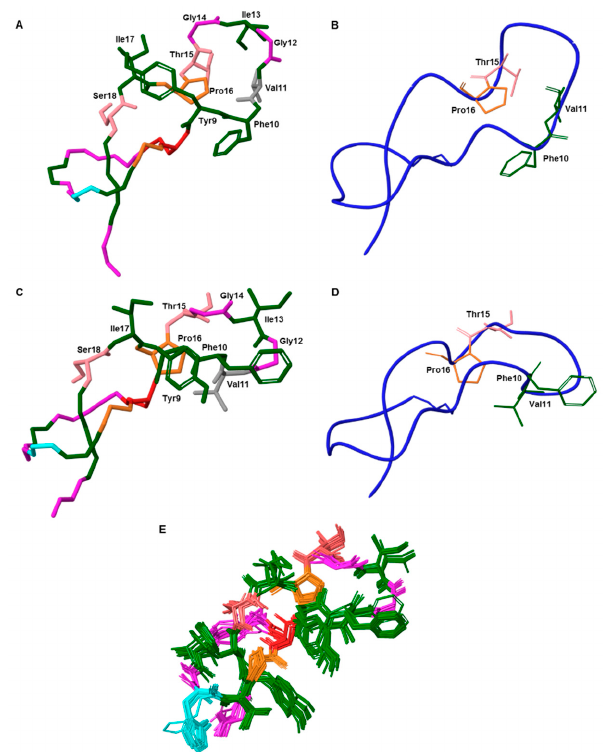
Figure 6. ( A ) and ( C ) 3D structure of the native MccJ25 (PDB code 1PP5) and NMR-derived lowest-energy structure of the new compound, respectively. Only the side chains of the loop are shown. ( B ) and ( D ) Ribbon representation of the native peptide and new compound, respectively. The four residues involved in the β -sheet located in the loop are shown. ( E ) Ensemble of the 20-lowest energy structures derived from the NMR restraints of the new compound. The maximum RMSD value between structures 1–20 is 0.6 Å. Aromatic and hydrophobic residues are shown in green, negatively charged residue (Glu8) in red, positively charged residues (His5) in blue, polar residues in light pink and non-polar residues in pink (Gly) and (Pro). In ( A ) and ( C ) Val11 residue is shown in grey.